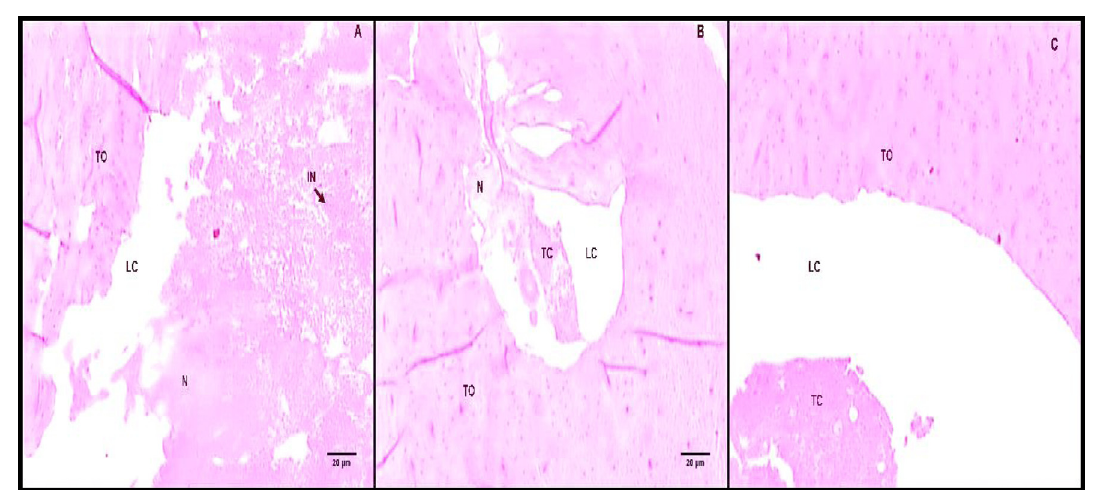
FIGURE 4 - Montage of photomicrographs of bone tissue sections from femurs of animals in Group 1 stained with hematoxylin-eosin, at 100x magnification. In A , control group on the seventh day after creating the lesion, showing details of primary bone (TO), area of inflammatory infiltrate (IN), area of tissue necrosis (N) and cavity lesion (LC). In B , control group on the fourteenth day after creating the lesion, showing details of primary bone (TO), area of tissue necrosis (N), cavity lesion (LC) and presence of conjunctive tissue. In C , control group on the twenty-eighth day after creating the lesion, showing primary bone (TO), area of tissue necrosis (N), cavity lesion (LC) and presence of conjunctive tissue. Scale bar = 20